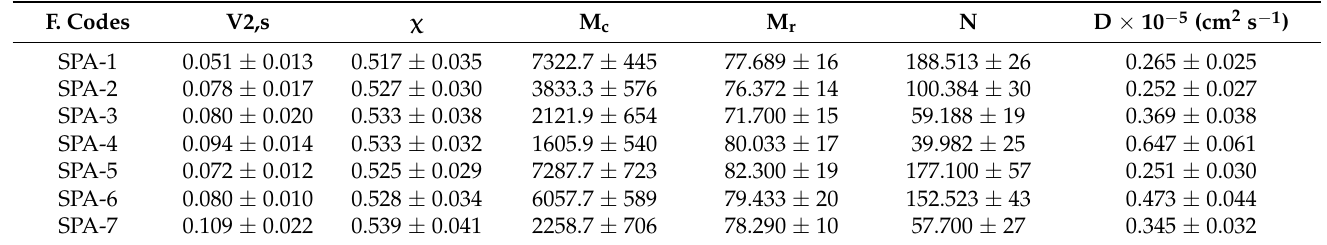
Table 2. Flory–Huggins polymeric network parameters of synthesized hydrogel